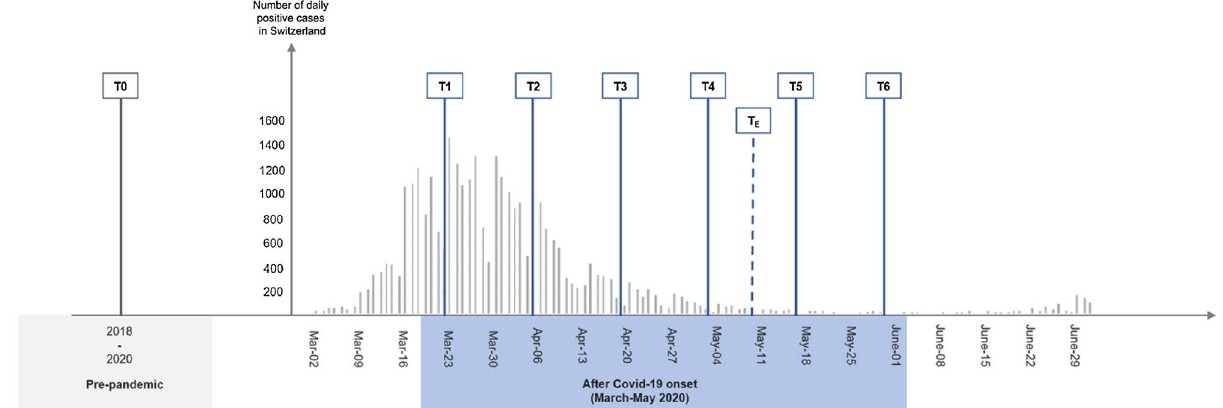
Figure 1. Study design and overview of assessment time points conducted prior to (T0) and during the pandemic and associated restrictive measures in Switzerland Assessments. Overall, eight testing time points are included, with the first (T0) reporting data obtained during the two years prior to the pandemic. Seven assessments were conducted across 75 days (11 weeks) after Covid-19 onset in Switzerland. The online assessment started following nationwide restrictions implemented in Switzerland on March 16th, 2020, including the ban of events, school closure, closure of all non-essential and hardware stores, garden centers, markets, museums, zoos, nightclubs, closure of hairdresser, restaurants, ban of gatherings (maximum of five people) and home-office orders, etc. Schools were re-opened on May 11th, 2020, resulting in more parents returning to work. Only assessments relevant to the present analyses are described below. Further details, including information for all assessments conducted prior to Covid-19 onset (T0) and during restrictions (T1–T6) may be found in the Supplementary Methods. Testing prior to Covid-19 (T0) took place between March 2018 and February 2020 and included functional neuroimaging during mentalizing. Online assessments after Covid-19 onset were conducted from March to May 2020. Participants filled out six biweekly online questionnaires (labelled as T1, T2, T3, T4, T5, T6 in Fig. 1). For adults, these targeted anxiety (State-Trait Anxiety Inventory or STAI-6; a self-report questionnaire to assess anxiety level as state 31 ), depression (Center for Epidemiologic Studies Depression Scale or CESD-R, German version 32 ; assessing symptoms in the last 1–2 weeks relating dysphoria, anhedonia, appetite, sleep, thinking, guilt, fatigue, movement and suicidal ideation), general health (General Health Questionnaire or GHQ-12, German version; a self-report instrument to screen for psychosocial well-being 33 ), distress (questionnaire adapted from the Kessler Psychological Distress Scale, but answer format was modified allowing participants to indicate their emotional state in relation to their usual emotional state 34 ) and subjective burden of caregiving for mothers (the Burden Scale for Family Caregivers or BSFC-s 35 ; a self-report questionnaire assessing subjective burden of fam- ily caregivers, which was adapted to capture increased burden in parental responsibilities during restrictions). In children emotional and behavioral problems were assessed using the Strengths and Difficulties Questionnaire (SDQ 36 ) and subjective mood ratings (children had to choose between 5 different smileys in order to indicate their mood in the last days. Ratings included 1: very happy, 2: happy, 3: unsure, 4: unhappy, 5: very sad). Children were further asked whether they had met any friends in the previous week. News consumption (adults only) and time spent outside (all participants) were assessed by asking participants to indicate the amount of time spent on these activities on a 5-point Likert scale. Adults reported their daily news consumption across all forms of media through the following scale: 1: no time, 2: approximately 15 min, 3: approximately 30 min, 4: approximately 1 h, 5: more than an hour of time spent consuming news). Adults and children indicated the average duration of spending time outside per day in the past week (1: no time, 2: half an hour, 3: 1 h, 4: 1–2 h, 5: more than 2 h of time spent outside). One extra questionnaire (T E , between T4 and T5) was added before a first ease in restrictions was introduced by the government. This extra testing consisted of the Child Behavior Checklist (CBCL 37 ) evaluating child behav‑ ior and the Fear of Illness and Virus Evaluation (developed by Professor Jill Ehrenreich-May, https:// adaa. org/ node/ 5168). CBCL was also acquired at T0 allowing a pre-/post-comparison. Of the six biweekly assessments, the last two (T5, T6) were conducted after schools reopened.